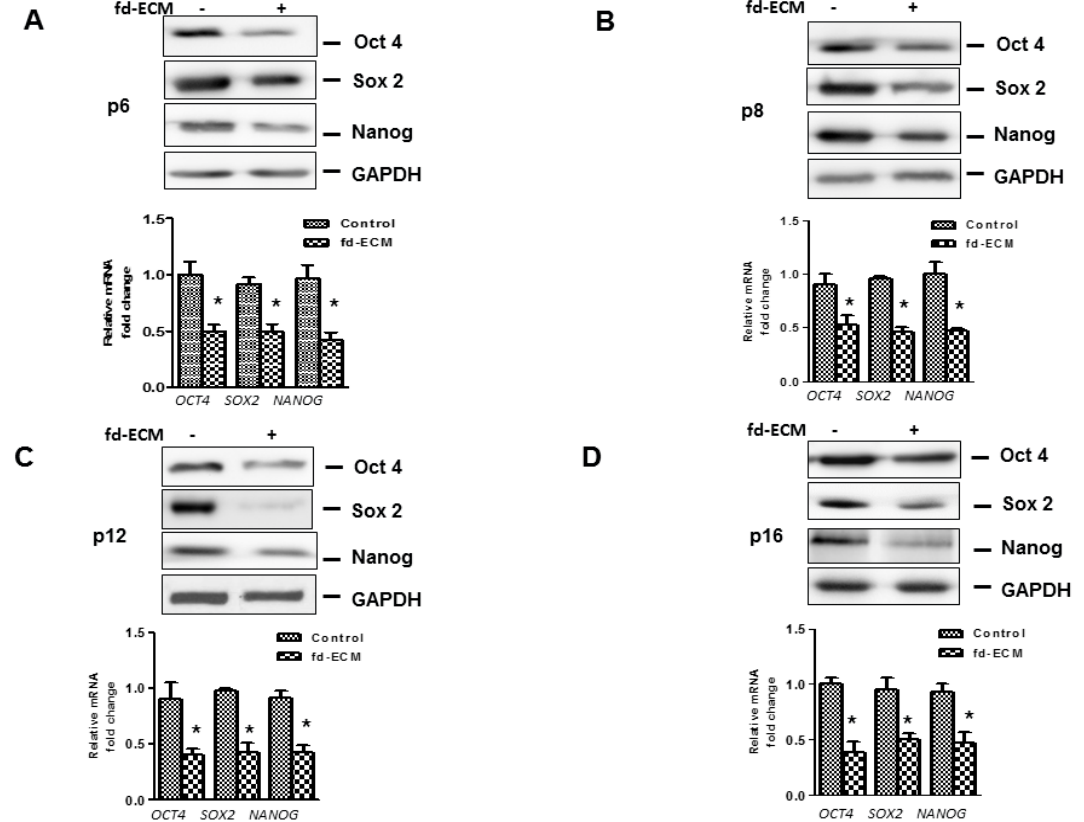
Figure 6. Fd-ECM downregulates pluripotency genes expression over several passages. Ad-MSCs were cultured on plastic dishes ( − ) or on fd-ECM (+) for the indicated passages ( A ) Protein and mRNA levels of Oct4, Sox2, and Nanog were determined in ad-MSCs lysates and mRNA at passage 6; ( B ) Protein and mRNA levels of OCT4 , SOX2 , and NANOG were evaluated in ad-MSCs lysates and mRNA at passage 8; ( C ) Protein and mRNA levels of OCT4 , SOX2 , and NANOG were evaluated in ad-MSCs lysates and mRNA at passage 12; and ( D ) Protein and mRNA levels of OCT4 , SOX2 , and NANOG were determined in ad-MSCs lysates and mRNA at passage 16. * p < 0.05.